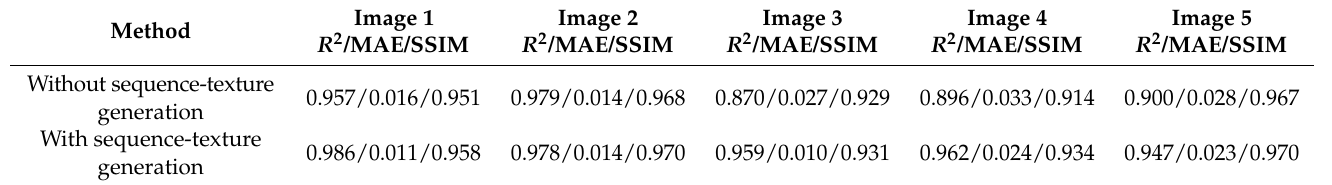
Table 5. Quantitative results of ablation study of sequence-texture generation network.